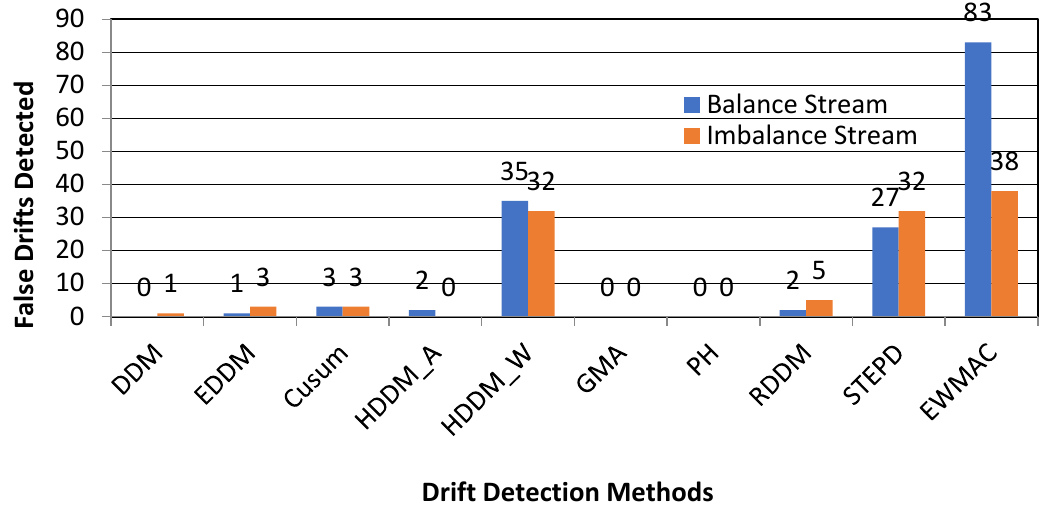
Figure 5. Number of false drifts detected by each method on balanced and imbalanced data streams.